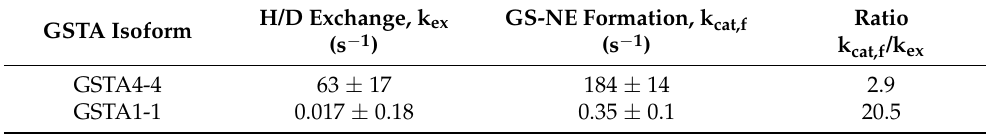
Table 2. Rate of 1 H-NE depletion (k ex ) and GS-NE formation (k cat,f ) and for GSTA4-4 and